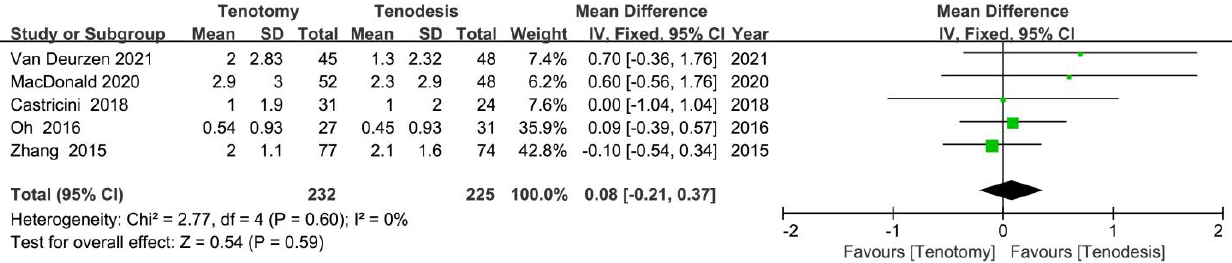
meta-analysis of randomised controlled trials. Green symbol: mean difference value; Black symbol: result of meta-analysis [18,19,22,30,32].